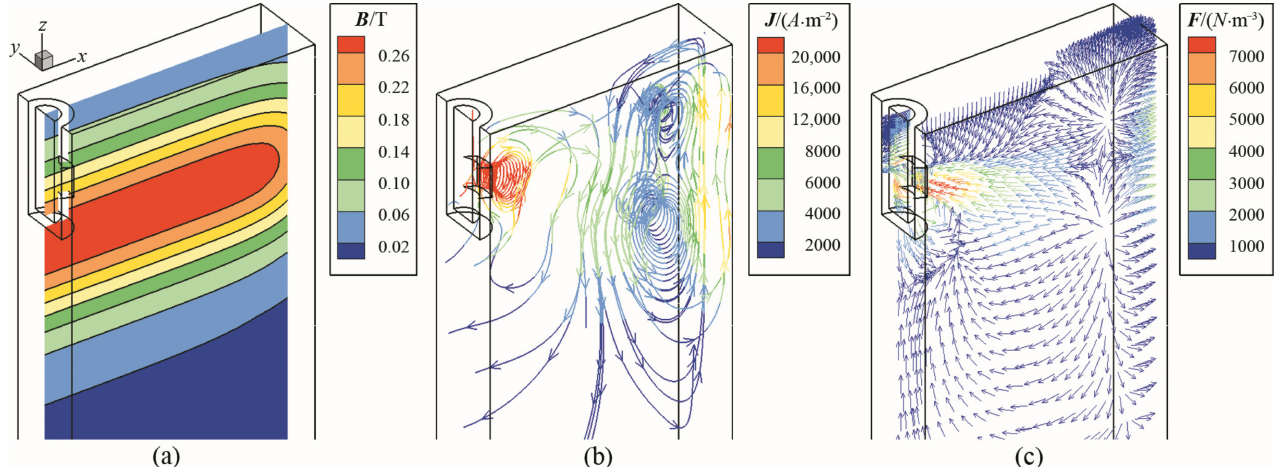
Figure 4. Electromagnetic characteristics in the mold with the magnetic flux density of 0.3 T: ( a ) mag- netic flux density, ( b ) induced current density, and ( c ) electromagnetic force.